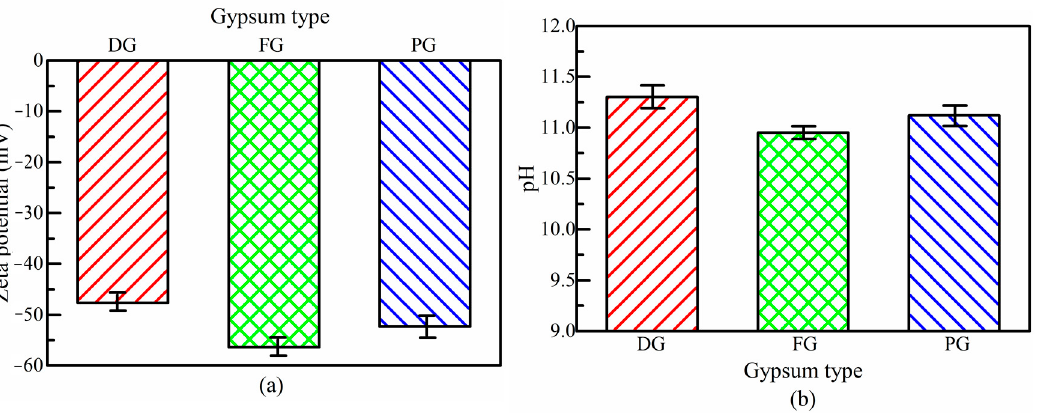
Figure 6. ( a ) Zeta potential and ( b ) pH value for fresh SSB-CPB with di ff erent gypsum types.